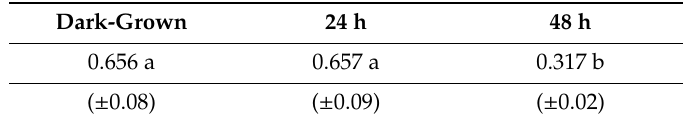
Data represent mean values from three experiments with five replicates (n = 15) expressed as µ g crystalline cellulose per mg of dry weight. Di ff erent letters signify values that are statistically di ff erent at p ≤ 0.05 according to Fisher’s LSD test. Values in the brackets represent ± standard deviation (SD).